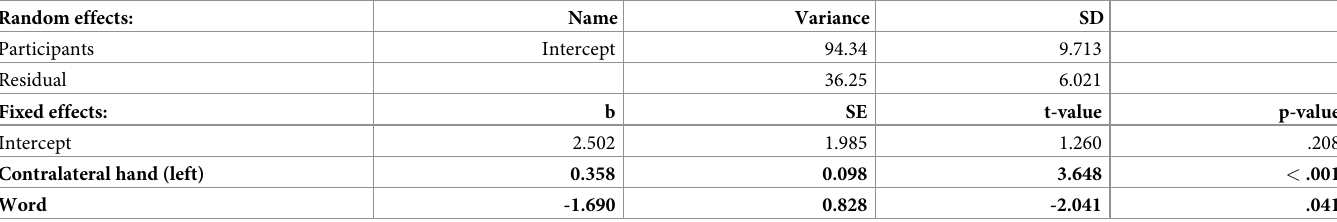
Table 13. Model 3.3. Effect of Direction on the right grip force (after controlling for the contralateral force) in the time window 250–300 ms (Experiment 3). Random effects: